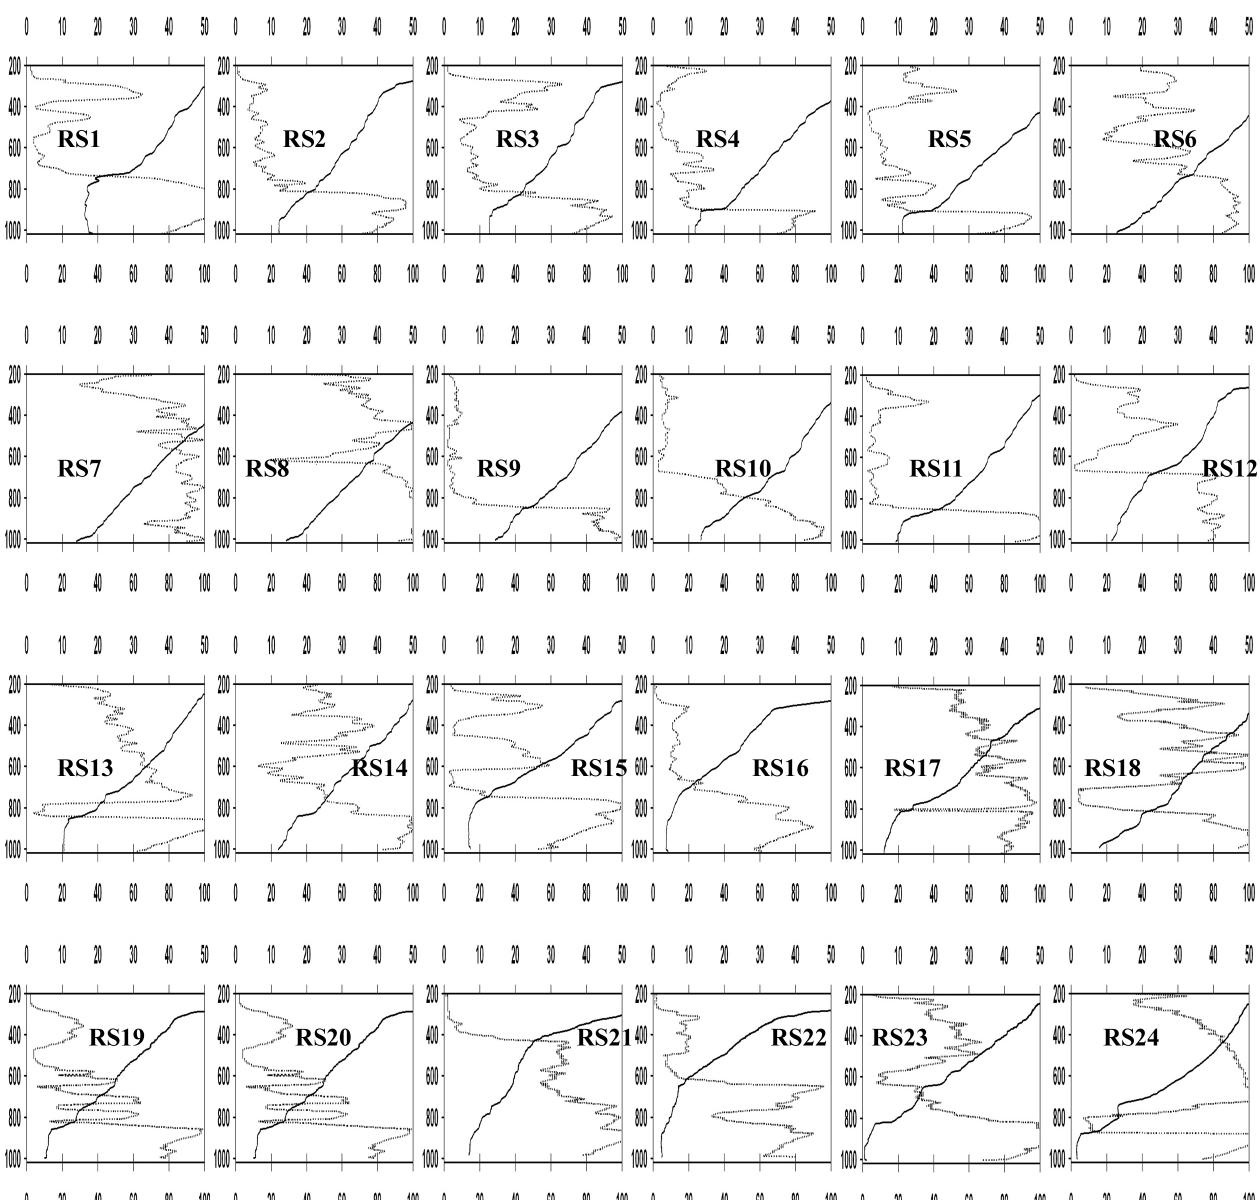
Fig. 3a. Vertical profile of potential temperature in ◦ C (bold line – upper horizontal axis) and relative humidity in % (dashed line – lower horizontal axis) for the 38 radiosondes. For locations, dates and times see Table 2. (a) for RS1 to RS24; (b) for RS25 to RS38.